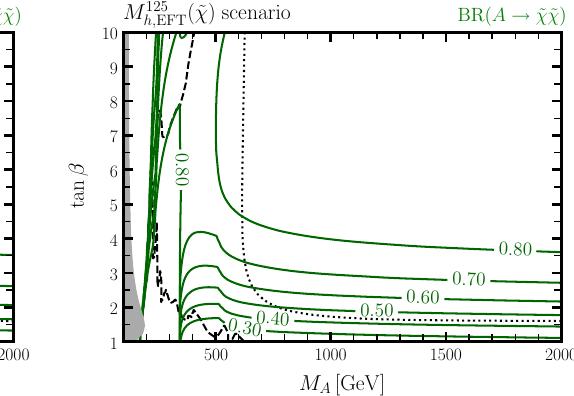
tions of electroweakinos in the final state are summed. In each plot, the gray exclusion region and the boundaries of the blue and the hatched ( ˜ χ) exclusionregions(shownas dashed and dottedblacklines ,respectively) h , EFT of Fig.4 are also